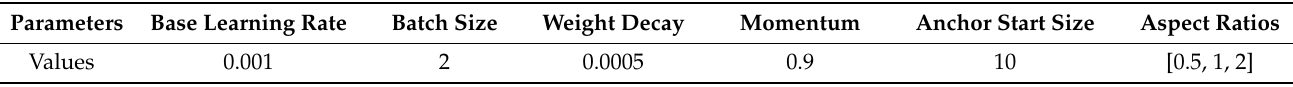
Table 2. Parameters of hat wearer detection with Faster R-CNN during the training process.